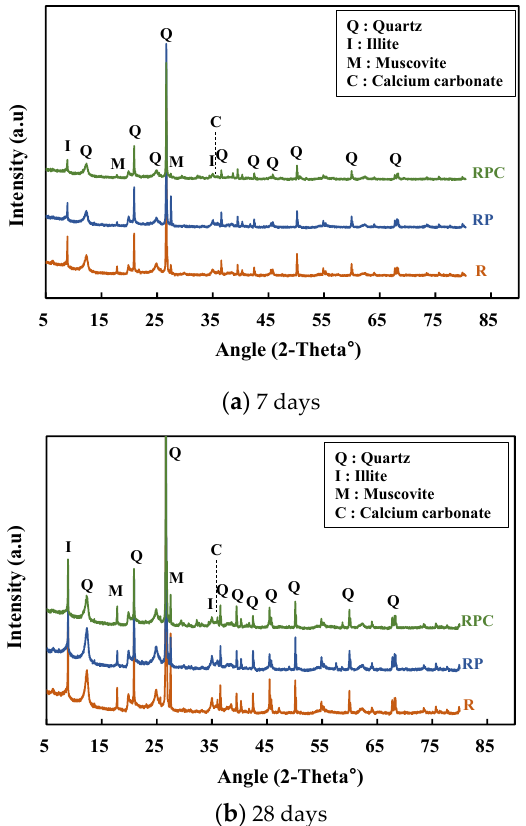
Figure 9. X-ray diffraction of specimens with the polymer aqueous solution.